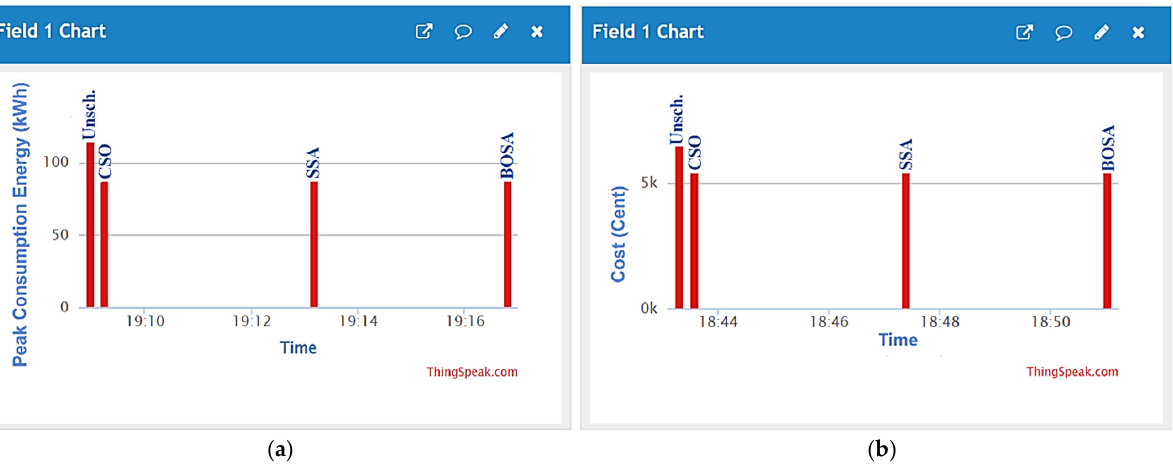
Figure 10. ( a ) Peak energy consumption and ( b ) electricity costs for both the unscheduled and sched- uled load profiles displayed via ThingSpeak platform.